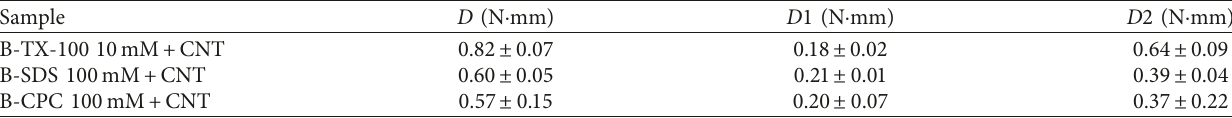
Table 2: Energy absorption capacity results for MWCNT-blended